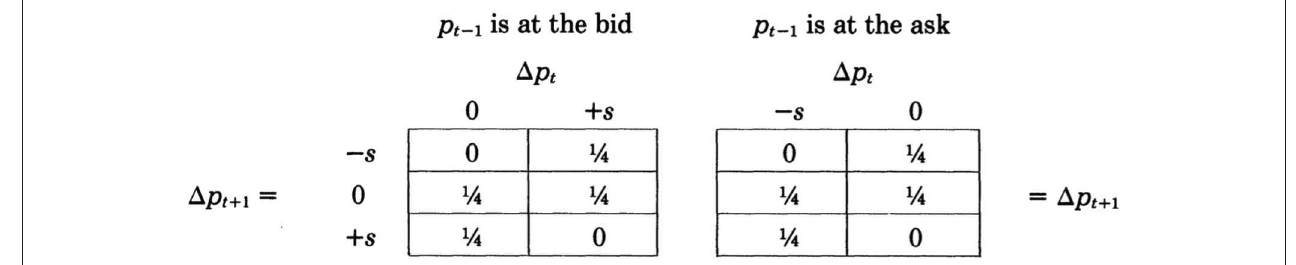
FIGURE 1 | Table of transition probabilities, conditional on the last transaction having been conducted at the bid or at the ask price, adapted from [72, p. 1129].